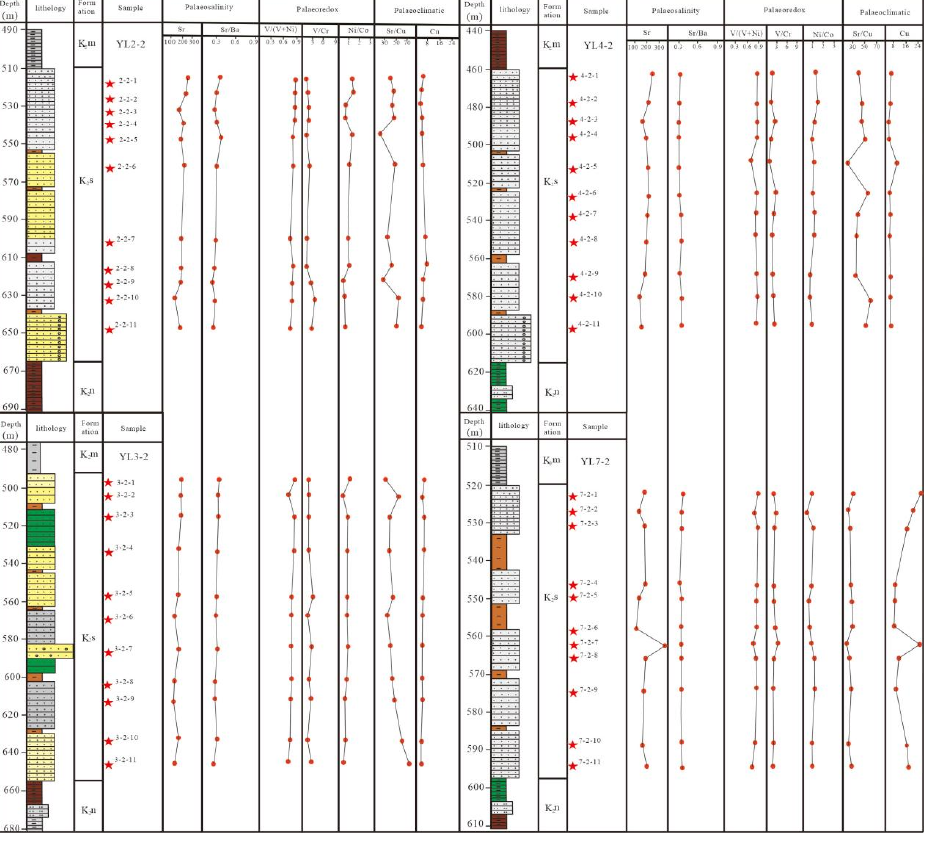
Figure 9. Discrimination diagram of the ratio of trace elements in the Sifangtai Formation sandstone in the study